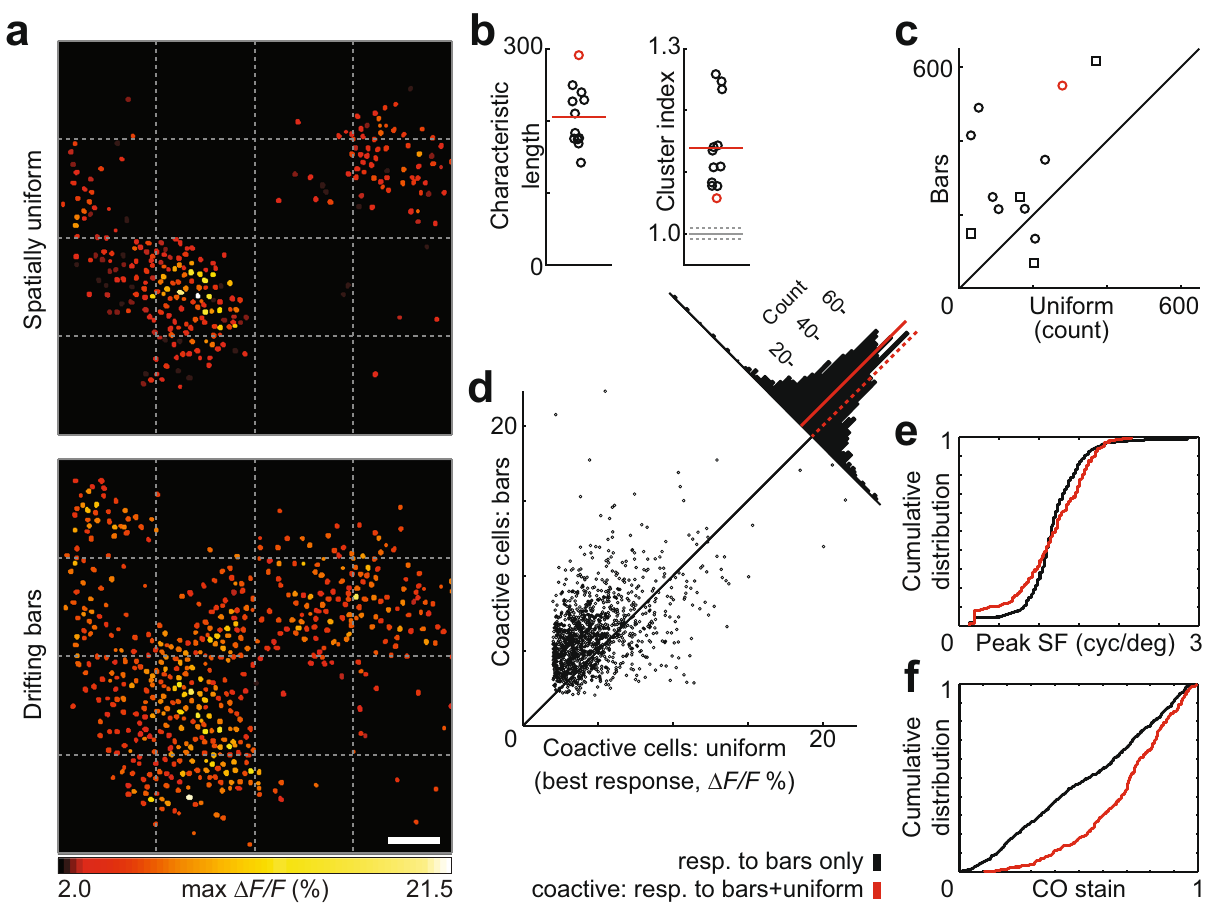
Fig. 4 Responses to spatially structured vs unstructured stimuli. a Upper: cell-based map of best response across all spatially uniform color conditions. Lower: best response of same cells to same color conditions presented as drifting bars (across four directions of motion). b Characteristic lengths for 12 FOVs with drifting bar stimuli (left). Clustering indices for same FOVs (right); gray line, mean clustering index for position-shuf fl ed controls; dotted gray lines, ±1 SD ( n = 12,000). Red lines, data means. c Number of responsive cells in same FOVs to uniform and bar stimuli. FOVs tested with four directions of motion are marked with circles, one direction of motion with squares. Red markers in b , c represent FOV in a . d Comparison of best responses to uniform and bar stimuli, same FOVs. Dashed red line marks zero difference, solid line marks mean (1.4%). e Cumulative distribution of peak achromatic spatial frequency preference for cells responsive only to chromatic bars (black line) or to both bars and uniform stimuli (red line). f Cumulative distribution of CO staining intensity for same set of cells. Scale bar, 100 μ m (shared in a ). Source data are provided as a Source Data fi